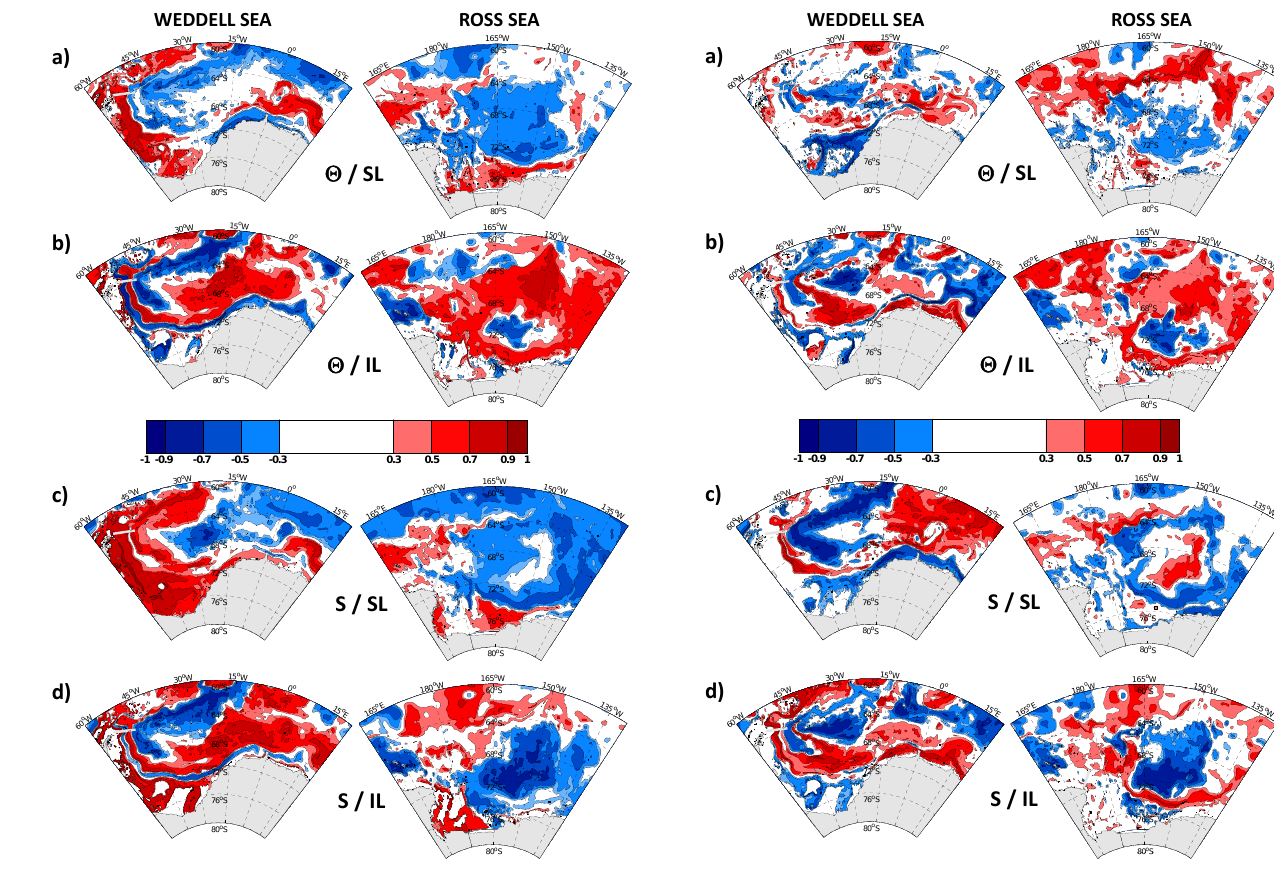
Fig. 18. Cross-correlation maps between model monthly mean bottom-layer volume transport at Weddell and Ross Seas cross- slope sections 1 and 13 (grey line), respectively, onto ( a and b ) potential temperature and ( c and d ) salinity at ( a and c ) SL depth and ( b and d ) IL depth. All correlations are calculated for zero lag. Only correlation coefficients at 95% significance level are shown.